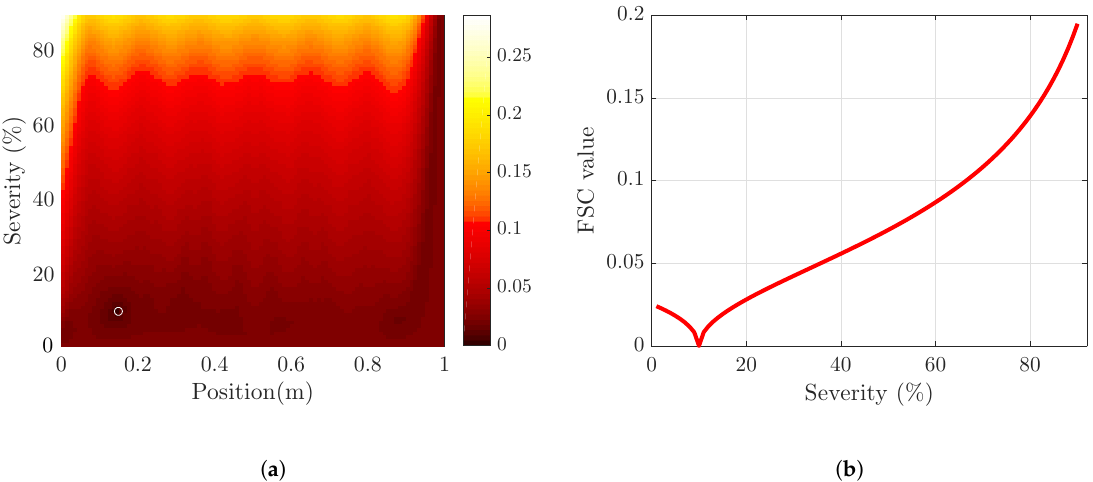
Figure 8. Frequency Shift Coefficient (FSC) as a function of tested position and severity, where ( a ) the white circle indicates 10% severity and 0.15 m position identified by the algorithm ( b ) slice view of 10% estimated damage.